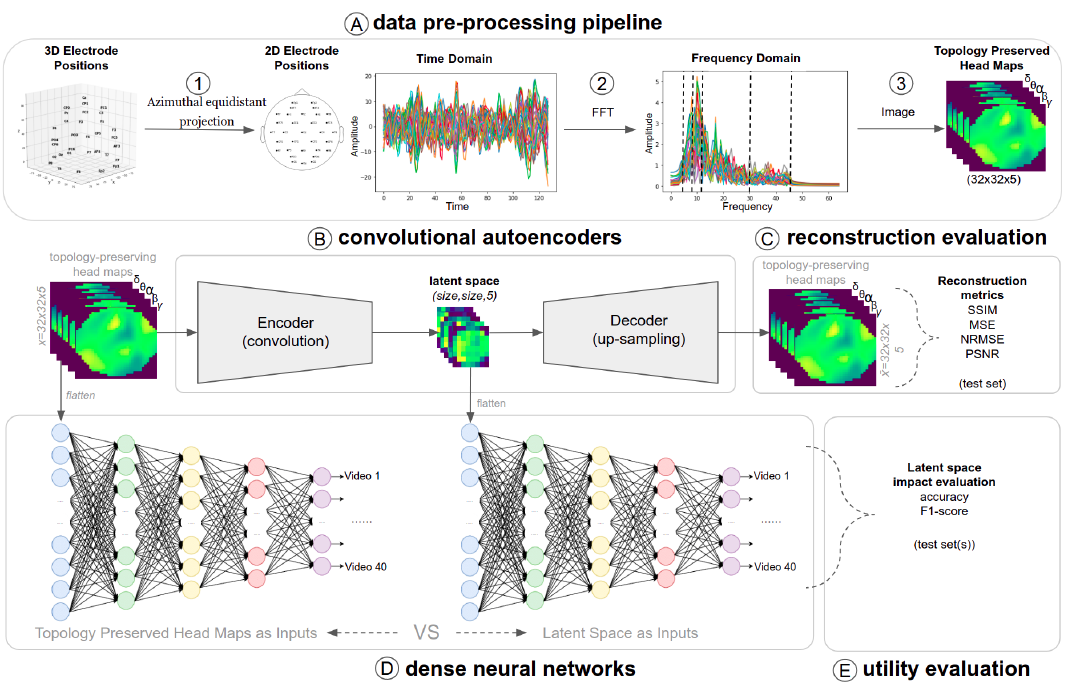
Figure 1. ( A ) Data pre-processing pipeline gives topographic head-maps (TPHM) as output from 32 channel EEG signals ( B ) ConvAE for obtaining the latent space ( C ) Reconstruction metrics to evaluate the latent space (LS) quality ( D ) DNN with LS and TPHM as inputs ( E ) Utility (U) to measure the model’s